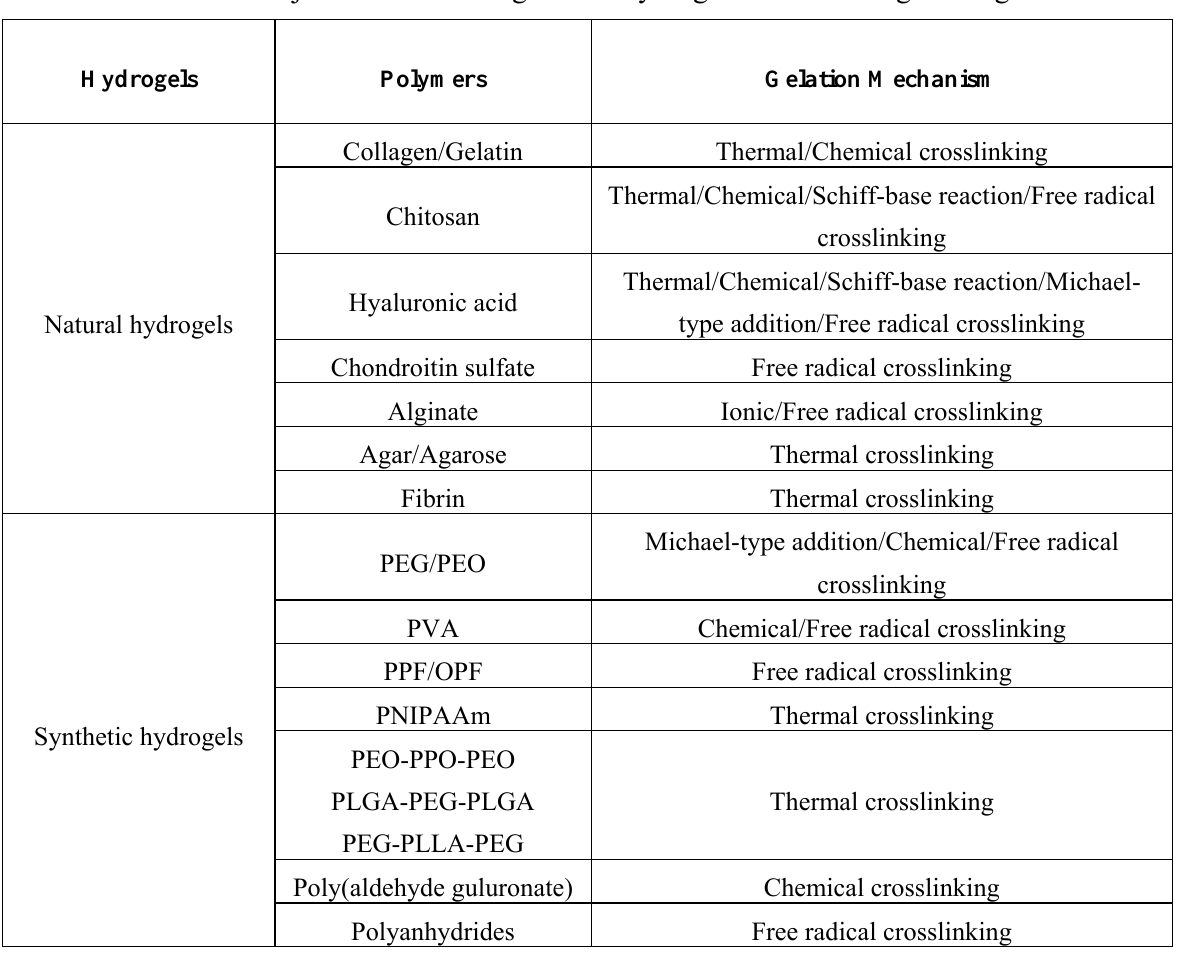
Table 1. Injectable and biodegradable hydrogels for tissue